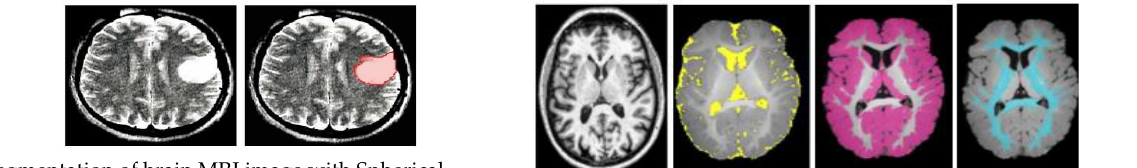
Segmentation of brain MRI image with graph cut approach: (left) Original MRI, (right) Segmentation result; illustration reproduced with the permission of Springer Nature [130].